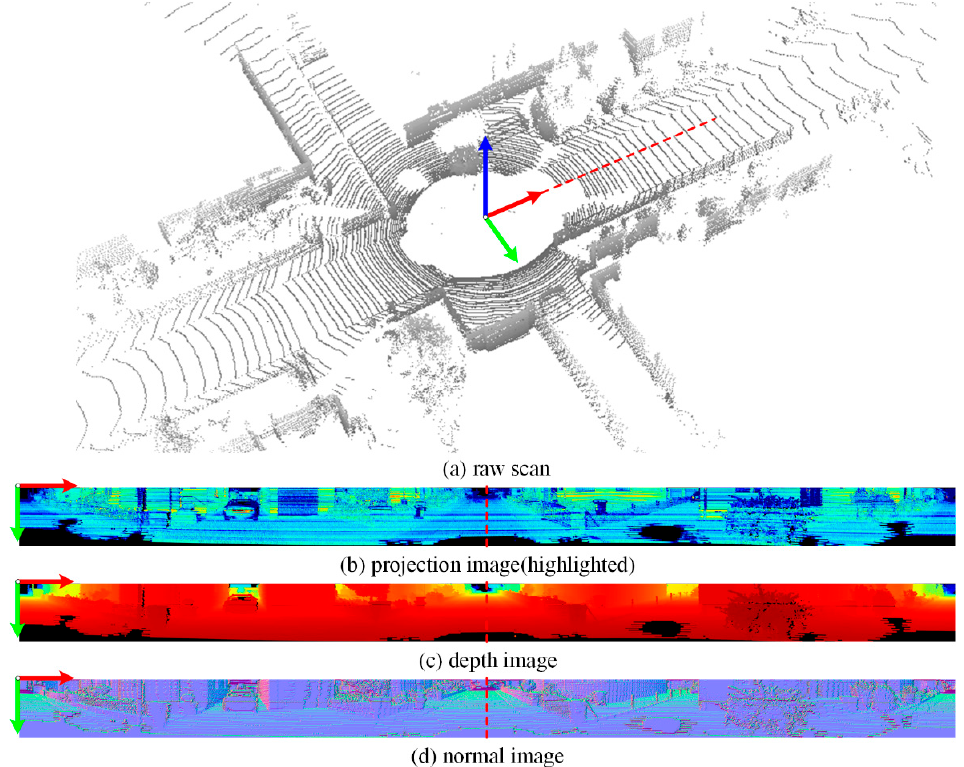
Figure 4. Spherical projection of LiDAR point cloud. ( a ) A raw scan from KITTI Dataset, ( b ) the corresponding projection image, colours in the visualization correspond to the remission, i.e., the brighter the colour, the higher the remission; ( c ) the corresponding depth image, colours in the visualization correspond to the range value, i.e., the darker the red, the closer the range; ( d ) the corresponding normal image, colours in the visualization correspond to the normal value, i.e., lilac are normal pointing upward (like the blue arrow in subgraph ( a )).